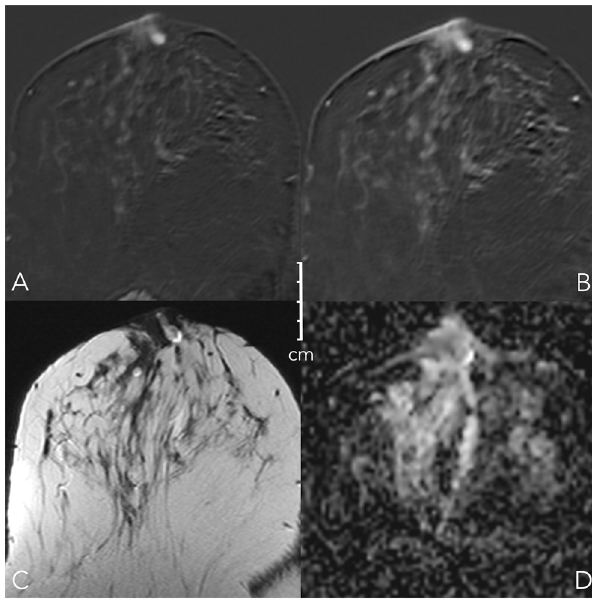
Fig. 10 Early (A) and delayed (B) contrast-enhanced subtractions, T2w (C), andADC map(D). Non-masslesioninthe left breastofa 25-year-old female with pain after stopping breast-feeding and unclear sonographic findings. The lesion shows no spiculations, a persistent enhancement curve type, and irregular margins, corresponding to a Kaiser score of 3 (Fig. 6). Note the internal small cystic correlate that suggests a benign lesion; ADC is unspecific (1.2*10 -3 mm 2 /s). Together with the clinical symptoms, periductal mastitis must be suspected and it is safe to assign BI-RADS 2. Due to personal preferences, the patient requested a biopsy that revealed chronic periductal mastitis,